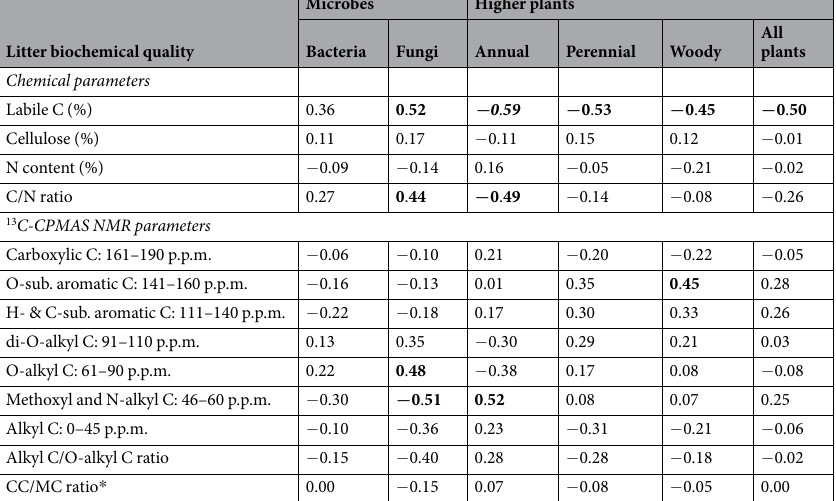
Table 2. Correlation (Pearson’s r) between bioassay results averaged for different target organisms (i.e. growth of bacteria, fungi and plant functional types) and biochemical quality of the 36 litter types assessed by proximate chemical parameters and 13 C-CPMAS NMR data. Bold indicates statistically significant values of r (p < 0.025, after controlling for multiple comparison according to Benjamini and Hochberg 74 ). * : CC ⁄ MC: O-alkyl C/ methoxyl and N-alkyl C